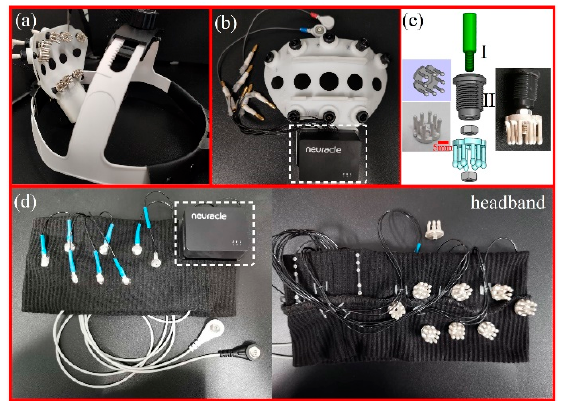
Figure 1. An adjustable electroencephalogram (EEG) cap and headband. ( a ) Photograph of the EEG cap; ( b ) the electrode panel with the eight adjustable electrodes and wireless acquisition module (as framed by the dotted line) on it; ( c ) the multi-pin dry electrode and a mechanically adjustable and electric connection structure, where part I is a tubular socket, part II is a hollow screw, and the left insert is the fabricated electrode and the right insert is the adjustable electrode; and ( d ) the textile headband for comparison. The dry electrodes and the wireless acquisition module are the same as those used for the cap.